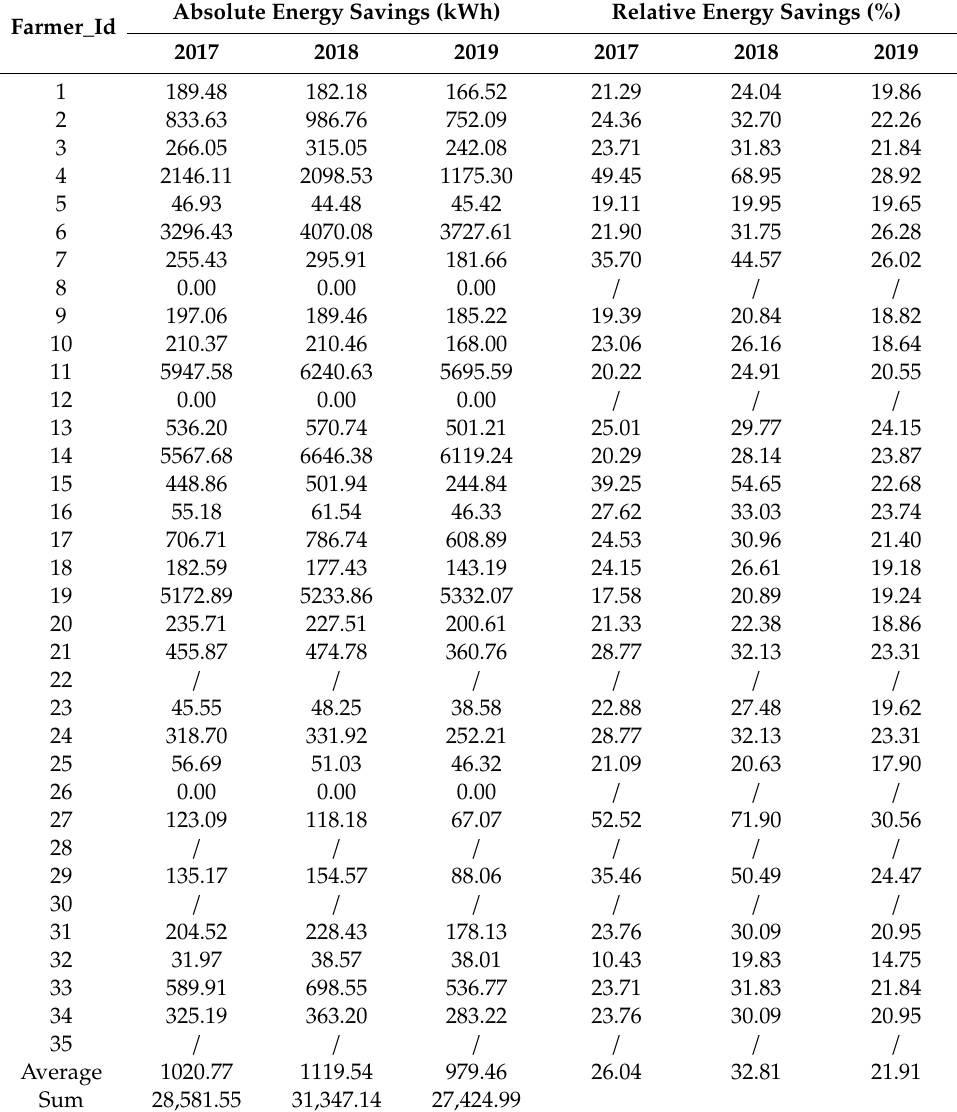
Table A10. Yearly absolute (m 3 ) and relative (%) energy savings at farm level if replenishing soil water content to 85% capacity (FC-WP) instead to